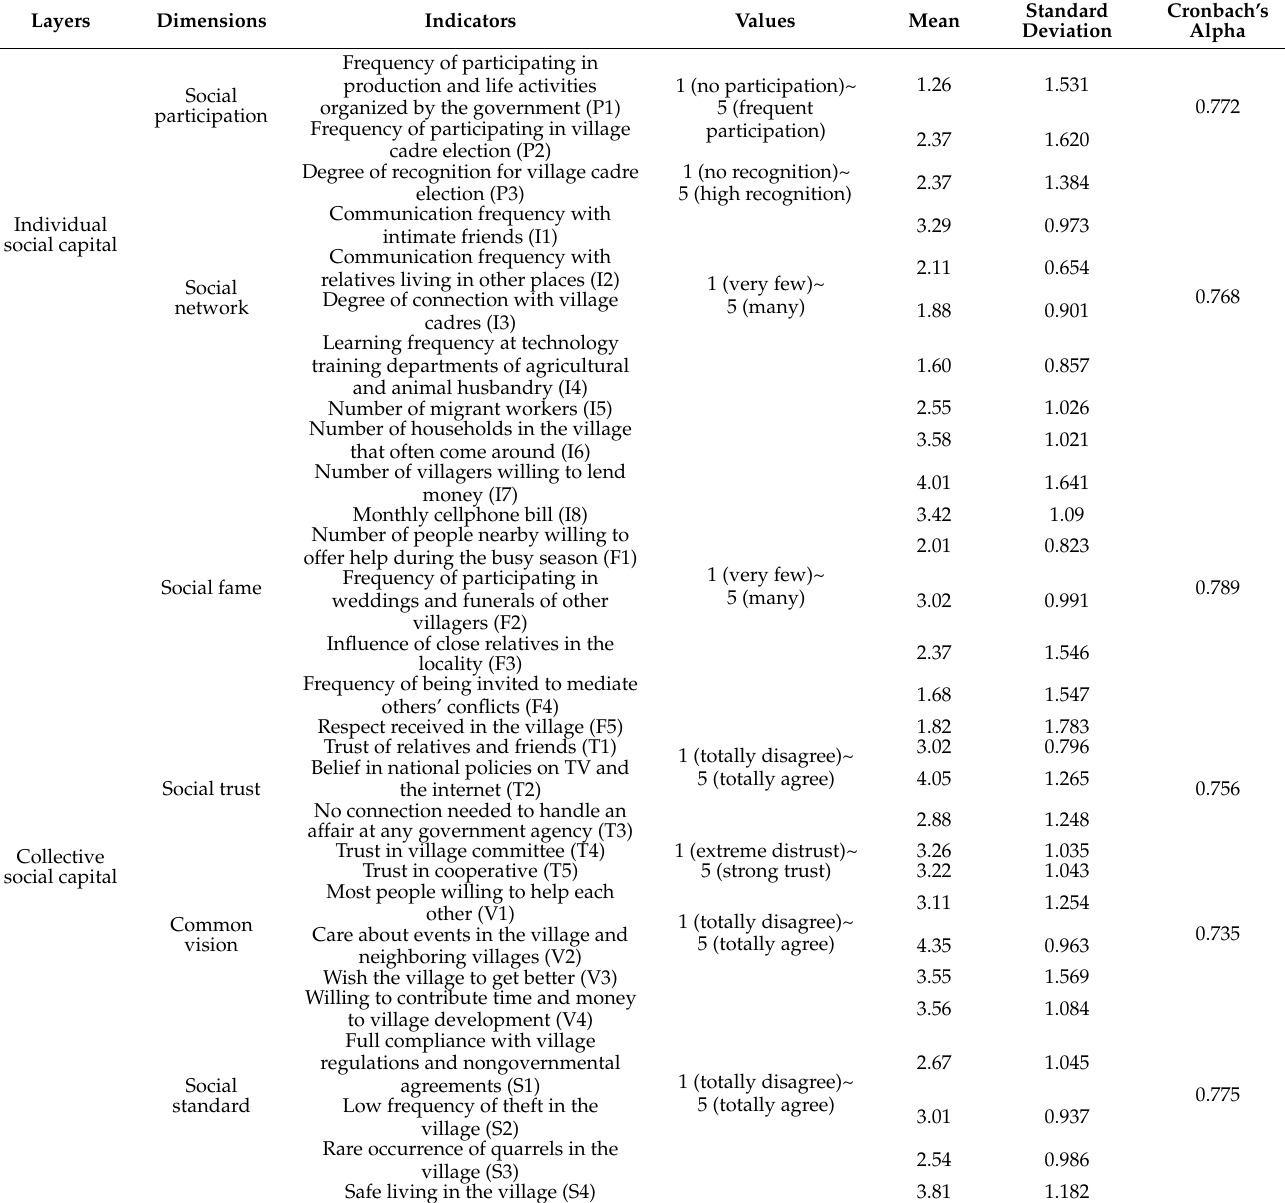
Table 2. Descriptive statistics of social capital